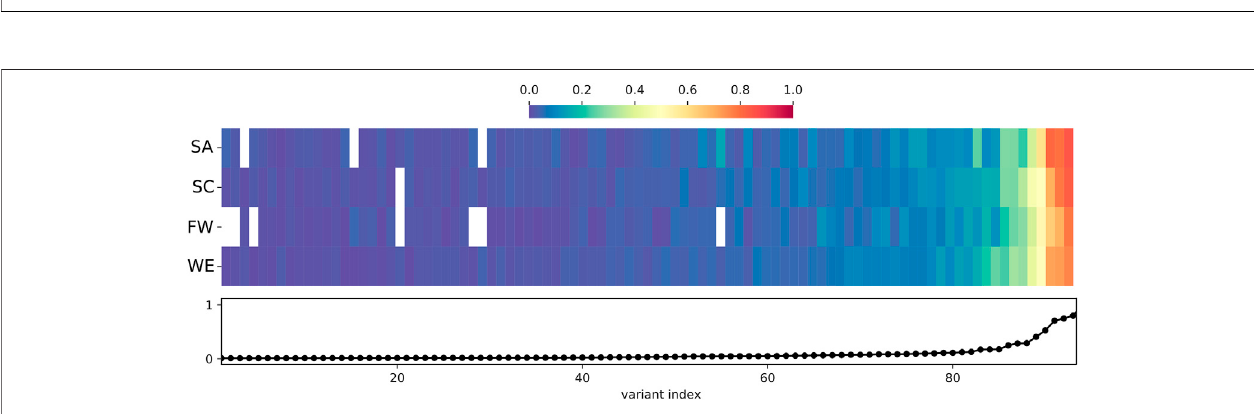
FIGURE4| Comparative discovery curvesofvariants inthecore ADME genes(including fl anks)for the (A) HAAD,the 1,000Genomes African and European data, and (B) in the combined HAAD and KGA datasets. The results show for a given number of haplotypes the number of variants seen per kilobase. The actual results are shown as a large dot, sub-samples by a solid line, and projections by a dotted line. Sub-samples values are computed averaging over 50 different randomly sampled subsets for intermediate values. Projection is computed using a third order jackknife projection (Burnham and Overton, 1979).